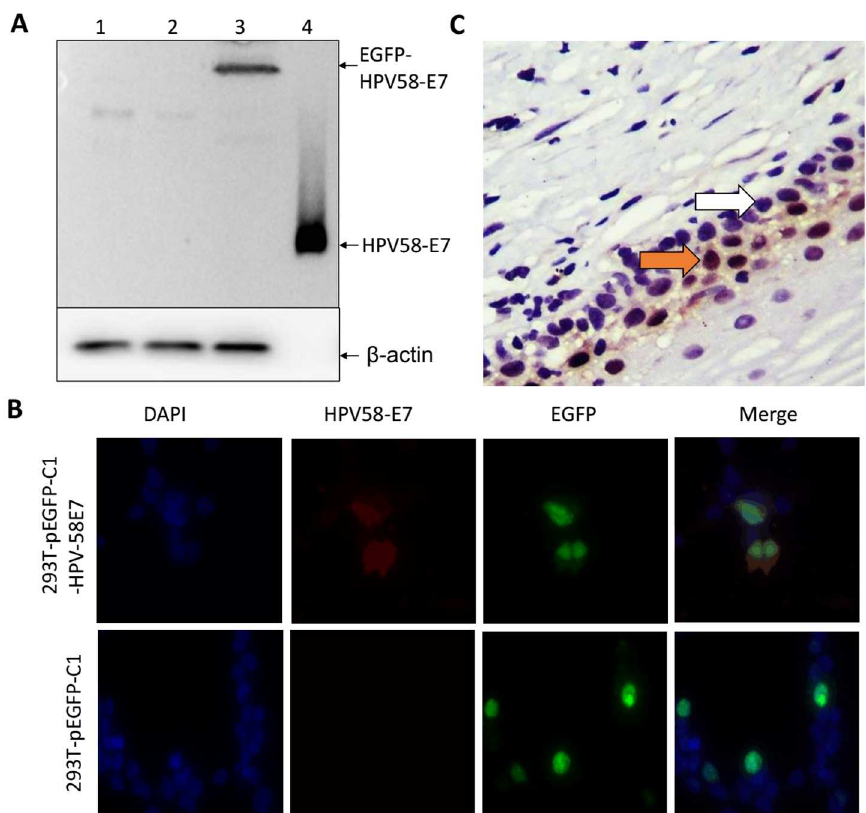
Fig 3. Verification of polyclonal antibody against HPV58 E7. (A) westernblottingfor the detectionof HPV58 E7. Lanes1, 2 and3 are the cell lysates of HEK293T,293T-pEGFP-C1, and293T-pEGFP-C1-HPV58-E7, respectively; Lane4 is the purifiedHPV58-E7protein.(B) Immunofluorescentanalysisfor the detectionof HPV58E7 in 293T-pEGFP-C1, 293T-pEGFP-C1-HPV58-E7cells. (C) Immunohistochemistry stainingfor the detectionof HPV58E7 in cervicalcancercells. Redarrowheads indicatethe HPV58-positive cells. White arrowheads indicatethe HPV58-negativecells.